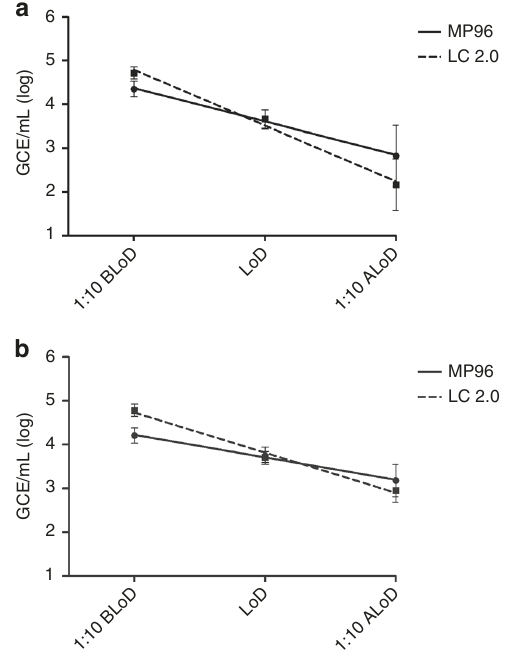
Fig. 3 Analytical performance comparison between MP96 and LC 2.0 RNA extraction platforms in whole blood (EDTA). A pool of whole blood donated by healthy donors was contrived with ZIKV at a dilution of 1:10 before the limit of detection (1:10 BLoD), at the limit of detection (LoD) and at 1:10 after the limit of detection (1:10 ALoD). Twenty replicas of every dilution were extracted using small volume protocol (0.2 mL) and tested with Trioplex assay on the ABI7500 Fast Dx instrument ( a ) or in the QuantStudio Dx instrument ( b ). Mean genome copy equivalents per milliliter (GCE/mL) of viral RNA detected are displayed at each dilution. Error bars represent GCE/mL standard deviation. Straight line represents linear regression of MP96 platform (Roche). Dashed line represents linear regression of LC 2.0 platform